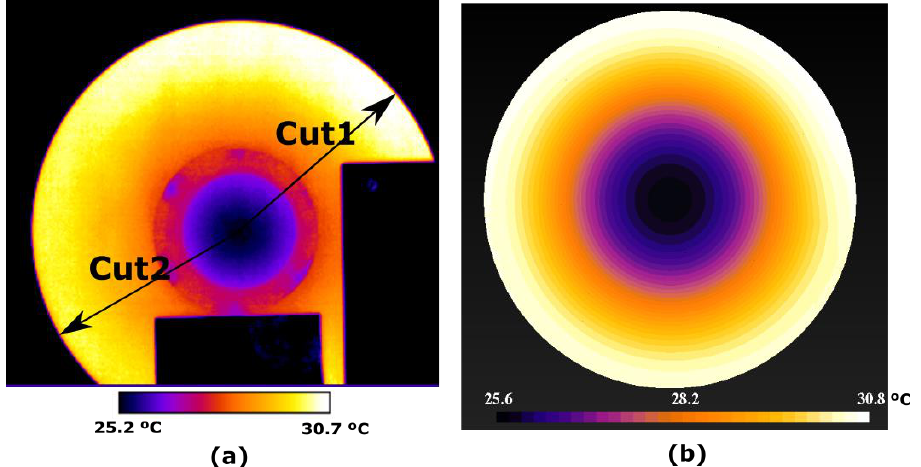
Figure 24. ( a ) Thermogram taken with the FLIR T425 camera at the instant 245 s compared with the simulation obtained under the same conditions by CM in ( b ), with d = 3 mm. The parametric cuts Cut1 and Cut2 are shown.